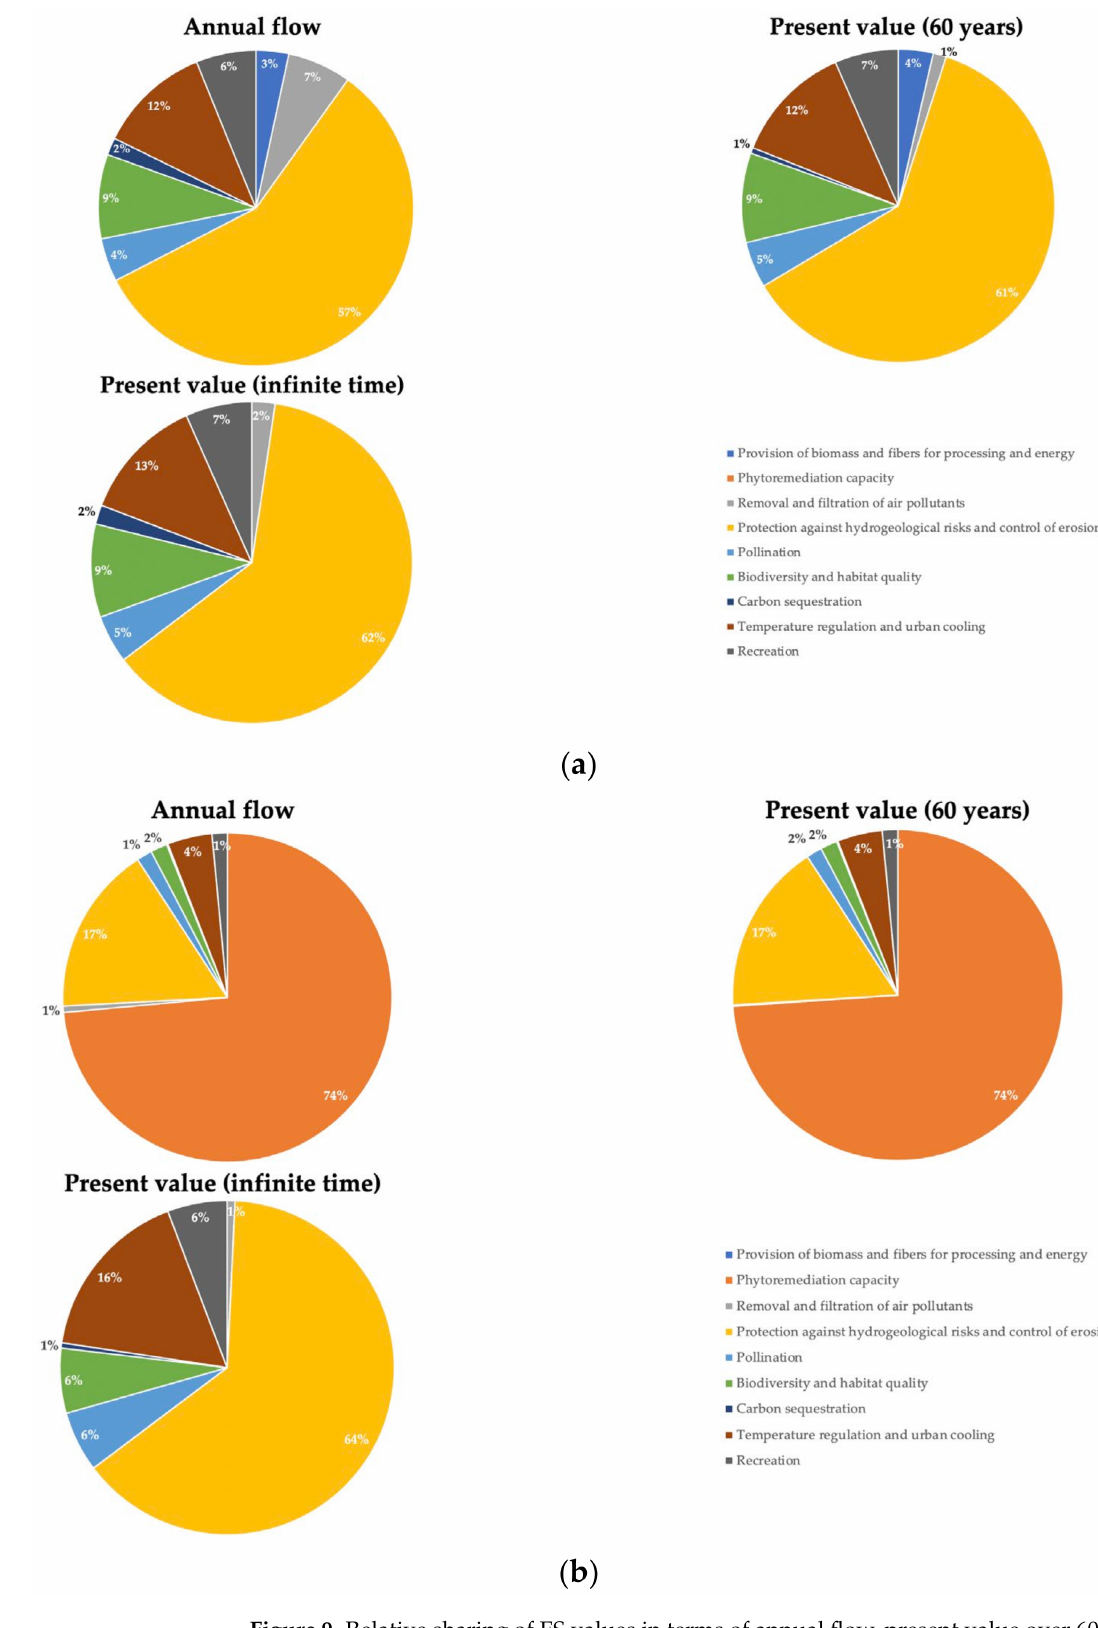
Figure 9. Relative sharing of ES values in terms of annual flow, present value over 60 years and an infinite time horizon for the two intervention scenarios. ( a ) Scenario 1—Urban forest, ( b ) Scenario 2—Meadows with sparse